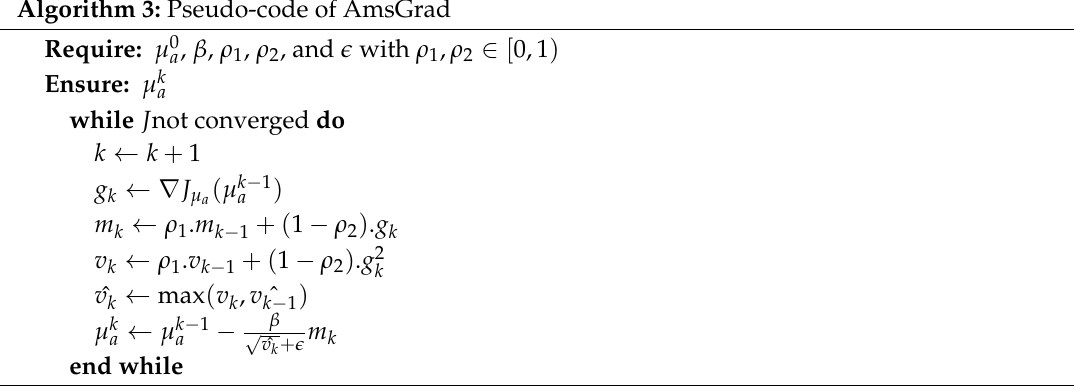
Algorithm 3: Pseudo-code of AmsGrad